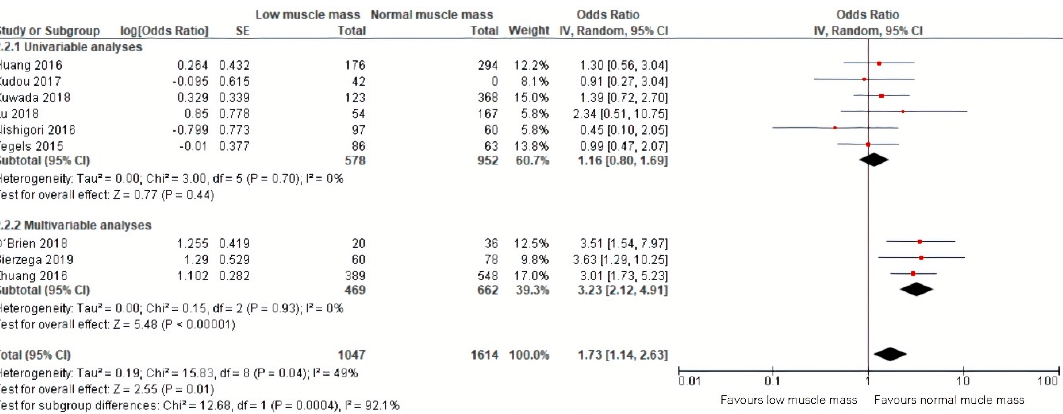
Figure 3. Forest plots of univariable and multivariable odds ratios for postoperative complications for gastric cancer patients with low muscle mass versus normal muscle mass.